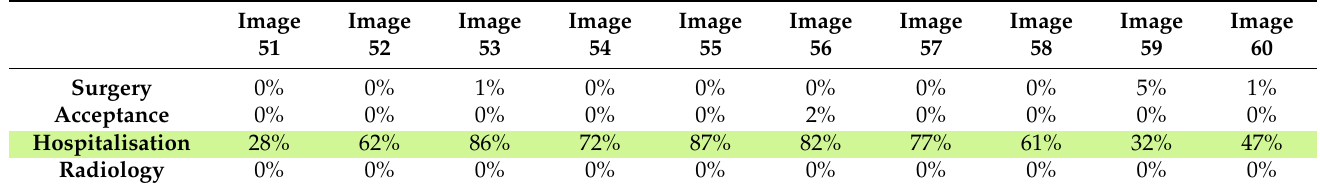
Table 11. Results obtained with the first version of the customised model for the “hospitalisation” IU. Each column refers to one of the test images (51 to 60) and each row shows the labels that were returned by the model. The row–column intersection shows the success rate in recognising the concept stated in the row for the image in that column.